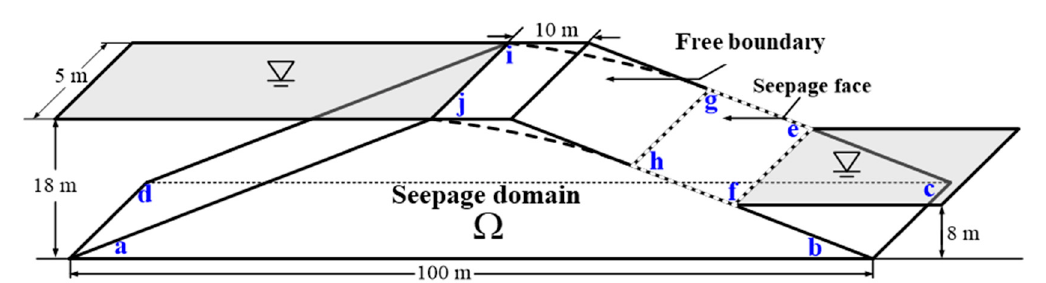
Figure 17. Flow through an earth dam in three–dimensions.